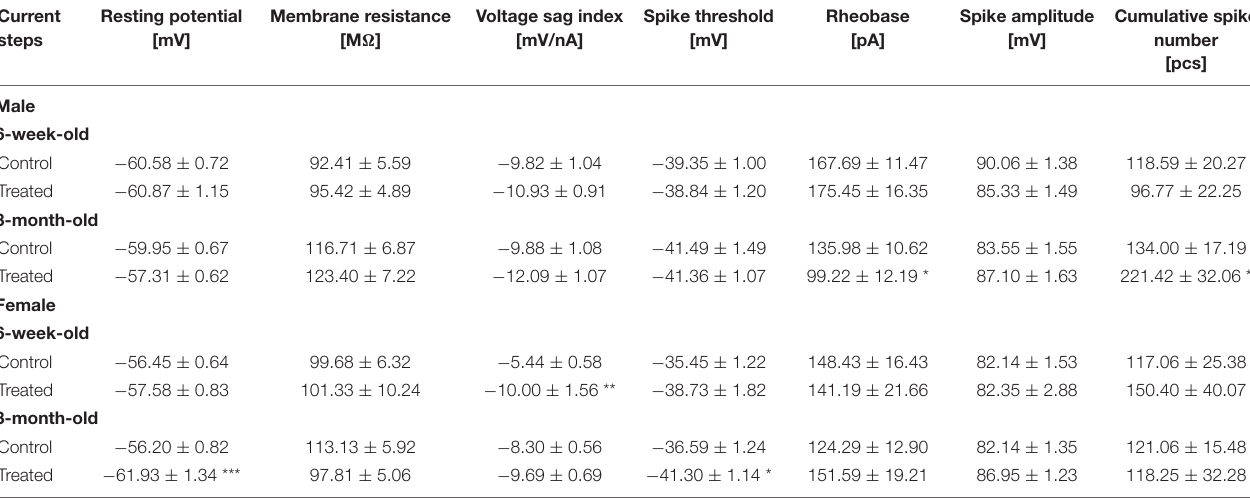
TABLE 1 | Intrinsic membrane properties of CA1 pyramidal cells measured in current clamp